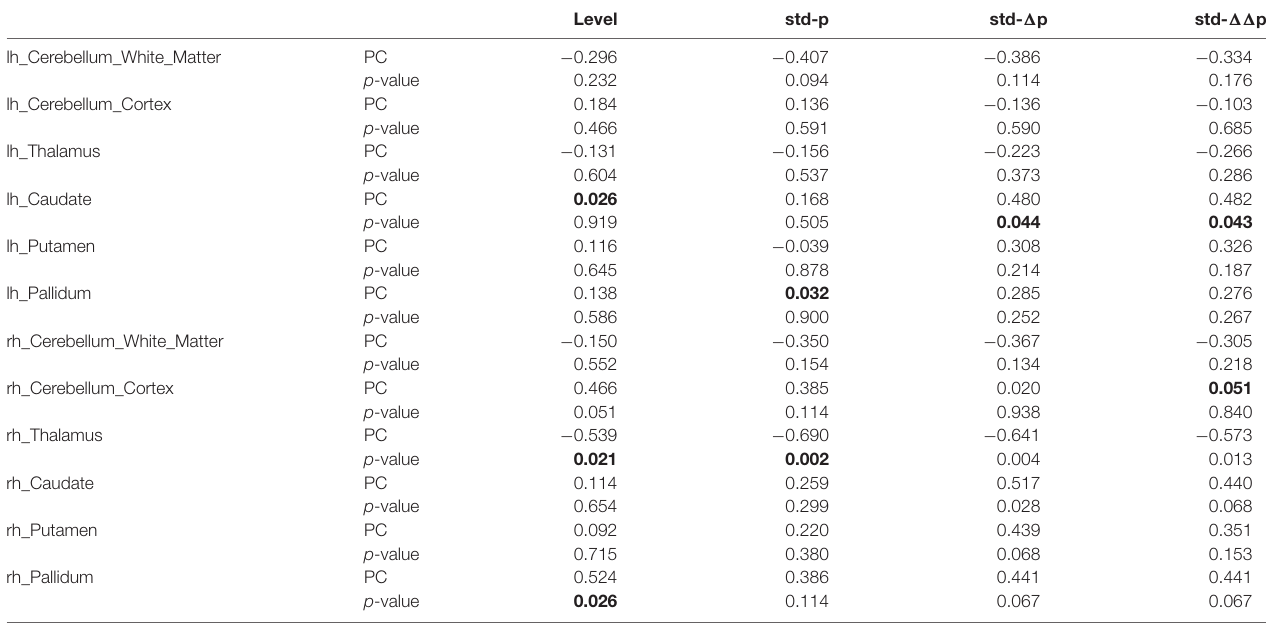
TABLE 4 | Pearson’s partial correlation (PC) analysis with brain volume correction for subcortical areas; significant values for p -value < 0.01 and p -value < 0.05 (bilateral). Level std-p std- ∆ p std- ∆∆ p